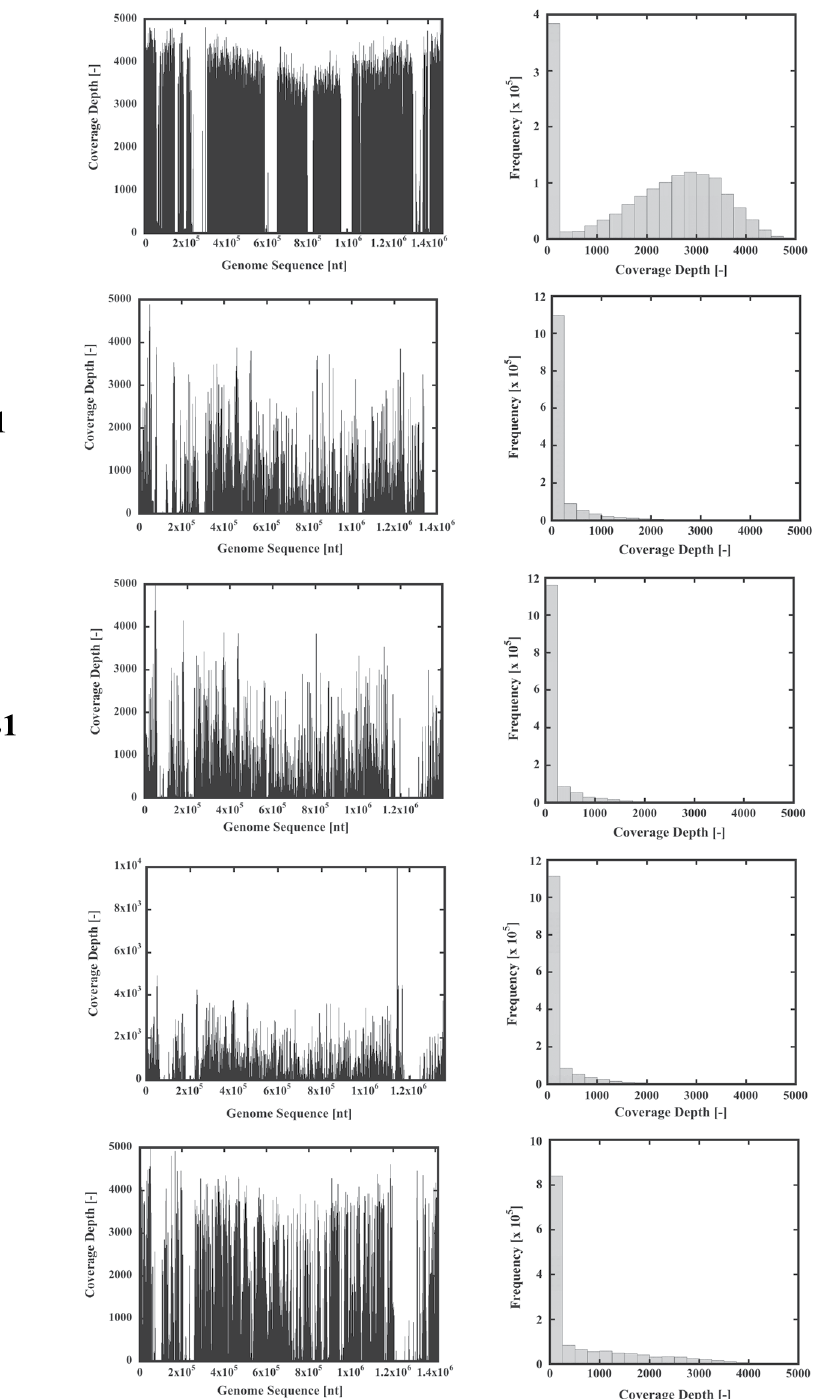
Figure 2. Comparison of consortium metagenome sequence data with the that of the Dehalococcoides sp. genome. Tag sequences for the metagenome of the consortium by SOLiD 3 Plus were matched to the genome sequences of five Dehalococcoides spp. ( D. mccartyi 195, D. mccartyi BAV1, D. mccartyi CBDB1, D. mccarty i GT, and D. mccartyi